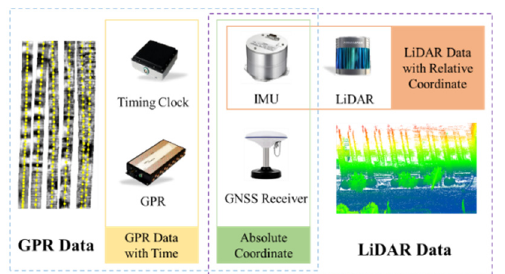
Figure 2. System data